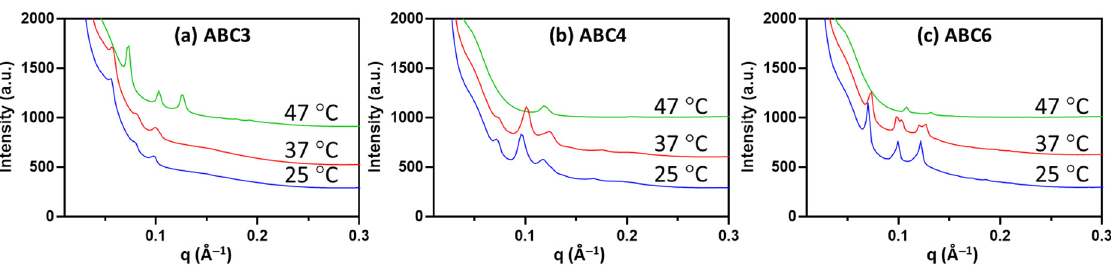
Figure 6. SAXS diffraction patterns of MO nanoparticles stabilized by 1.5 mol% ABC3 ( a ), 1.5 mol% ABC4 ( b ) and 1.5 mol% ABC6 ( c ) at neutral pH measured at three temperatures.